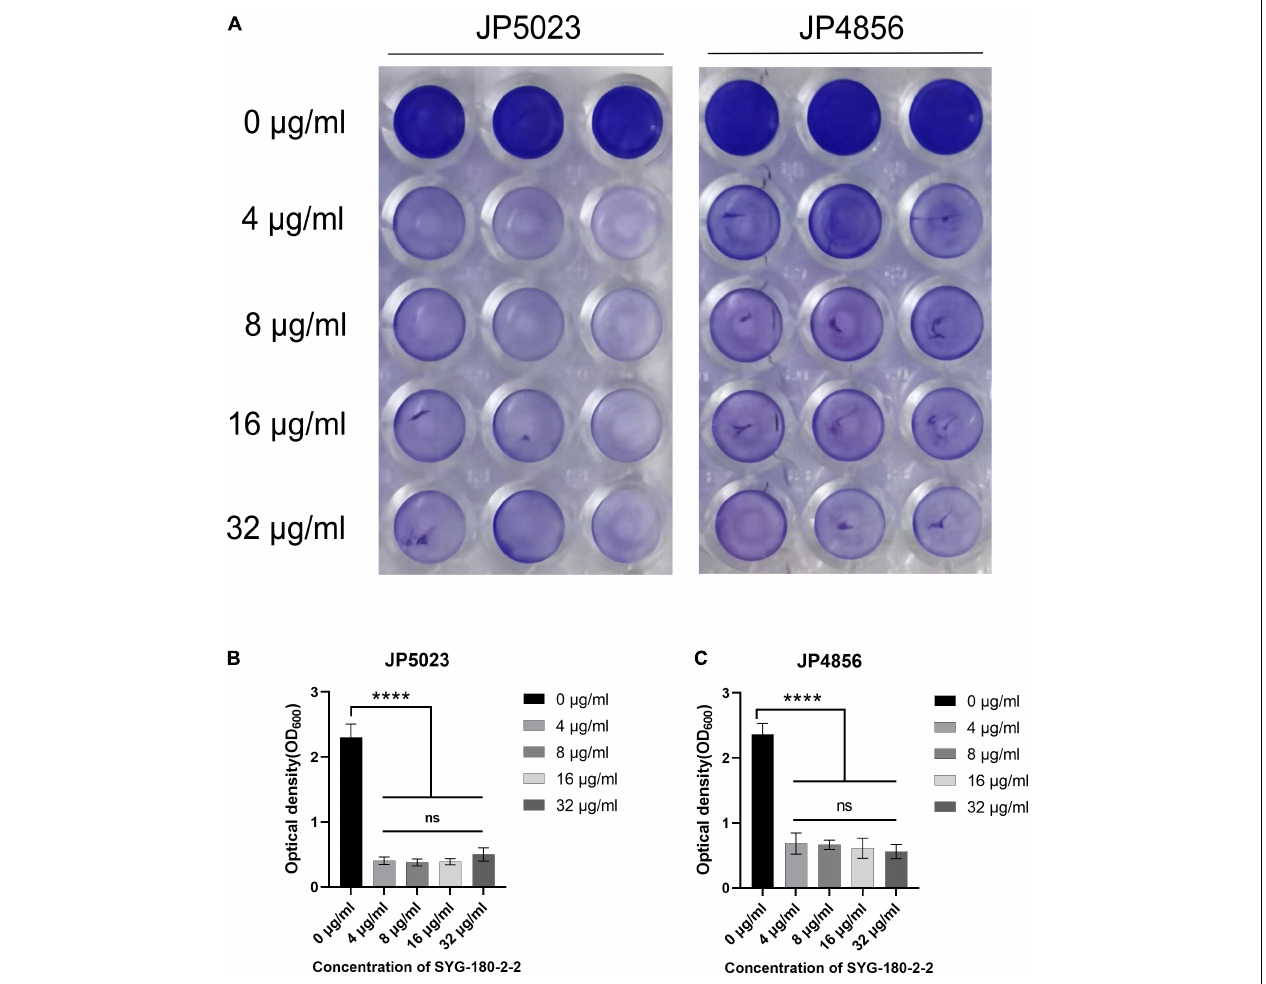
FIGURE 5 | The effect of SYG-180-2-2 on the formation of biofilm. (A) Biofilm formation in a 96-well plate. At OD 600 , there was a significant difference in the biofilm formation of JP5023 (B) and JP4856 (C) cultured with or without SYG-180-2-2. **** P < 0.0001.